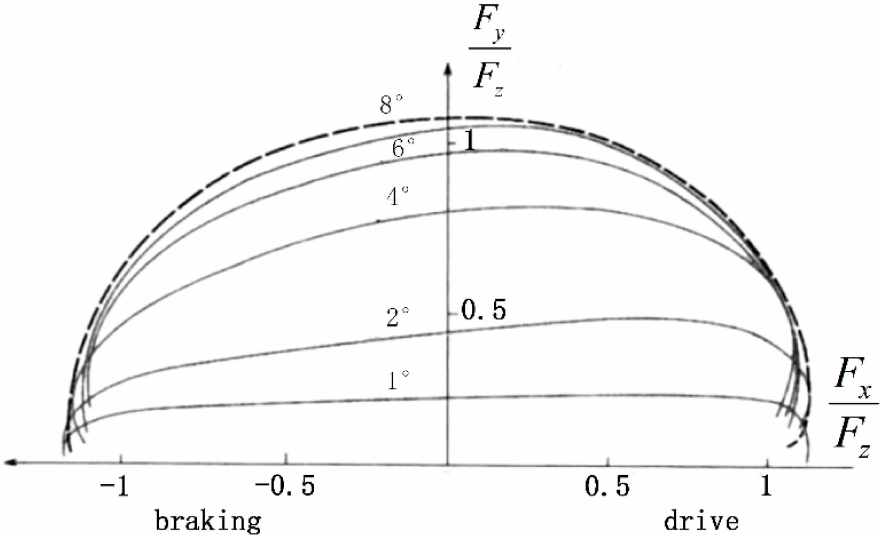
Figure 10. Distribution of longitudinal and lateral adhesion coefficient limits (friction